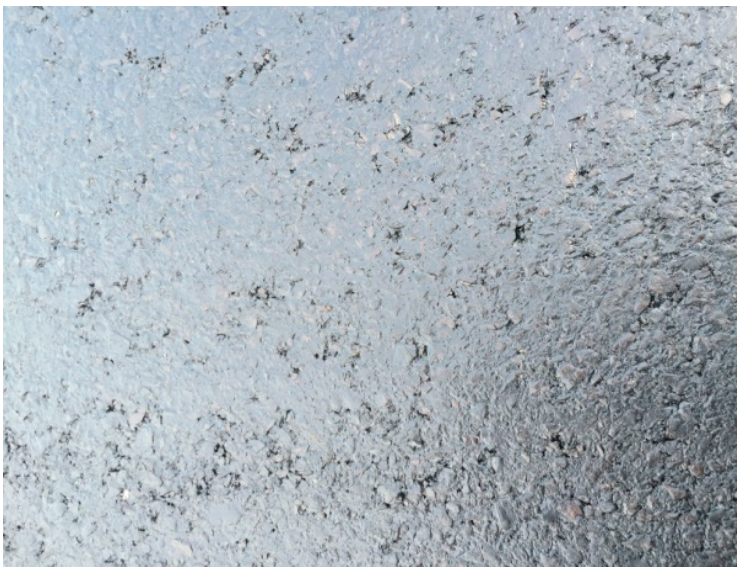
Figure 6. Effect of paving using the high-modulus asphalt mixture.